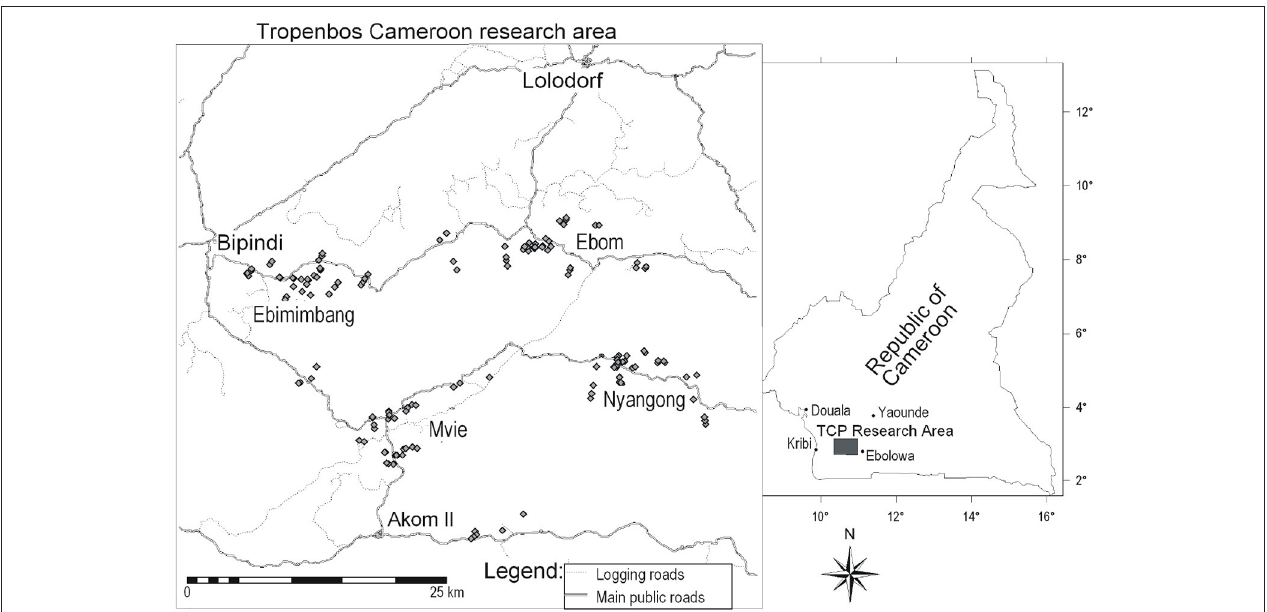
FIGURE 1 | Location of the study areas and spatial distribution pattern of sample points (small diamonds in the sample area map).